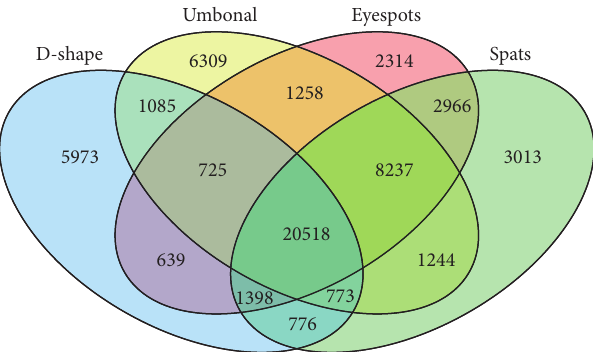
Figure 7: Specific and shared genes in five developmental stages of the pearl oyster, Pinctada fucata